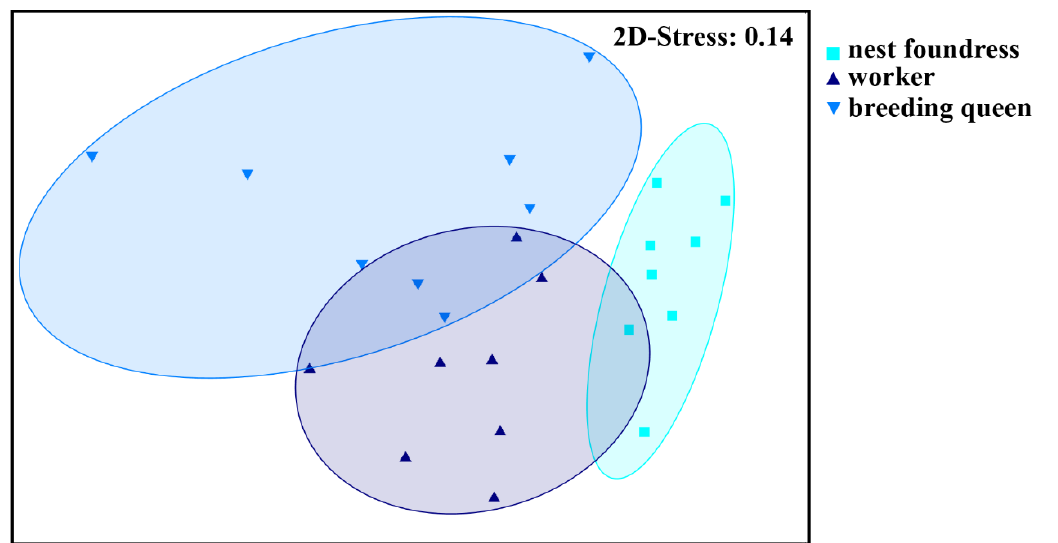
Figure 1. Differences in cuticular chemical profiles among nest foundresses, workers, and breeding queens of the halictid bee L. pauxillum (NMDS, Bray–Curtis similarity measures, 2D-Stress: 0.14). All tested female groups could be separated on the basis of the relative amounts of the chemical compounds found on their cuticle surfaces (ANOSIM, global R = 0.493, p < 0.001, foundresses vs. breeding queens: p < 0.001, foundresses vs. workers: p < 0.001, breeding queens vs. workers: p = 0.015).